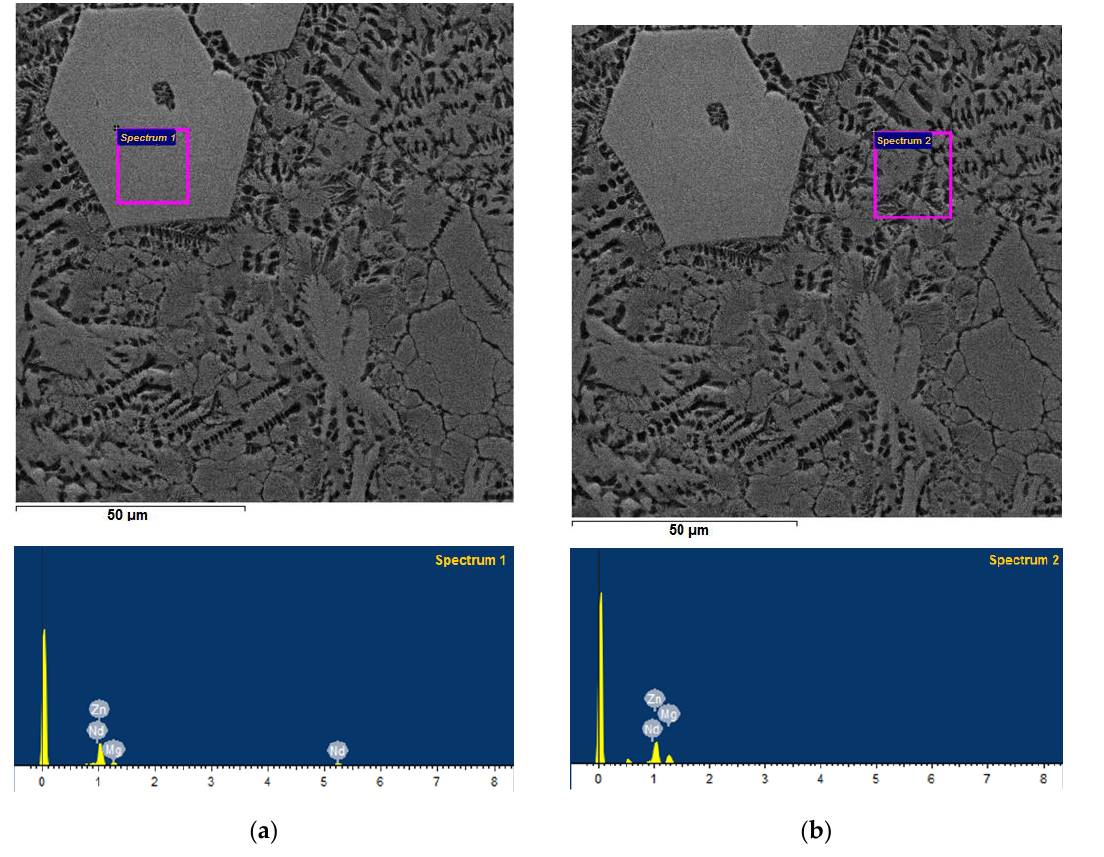
Figure 6. Electronic images of the microstructure of the 25Mg–50Zn–25Nd master alloy ( a ) and ( b )— ×2000. Table 4. Values of spectra of Mg–Zn–Nd master alloy.